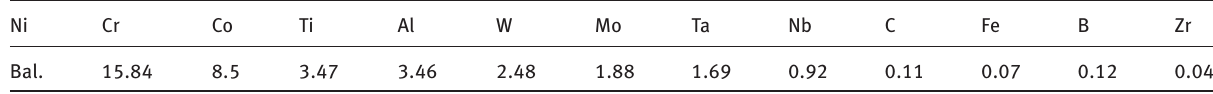
Table 1: Chemical composition in weight% of the as-cast Inconel 738 Ni Cr Co Ti Al W Mo Bal.